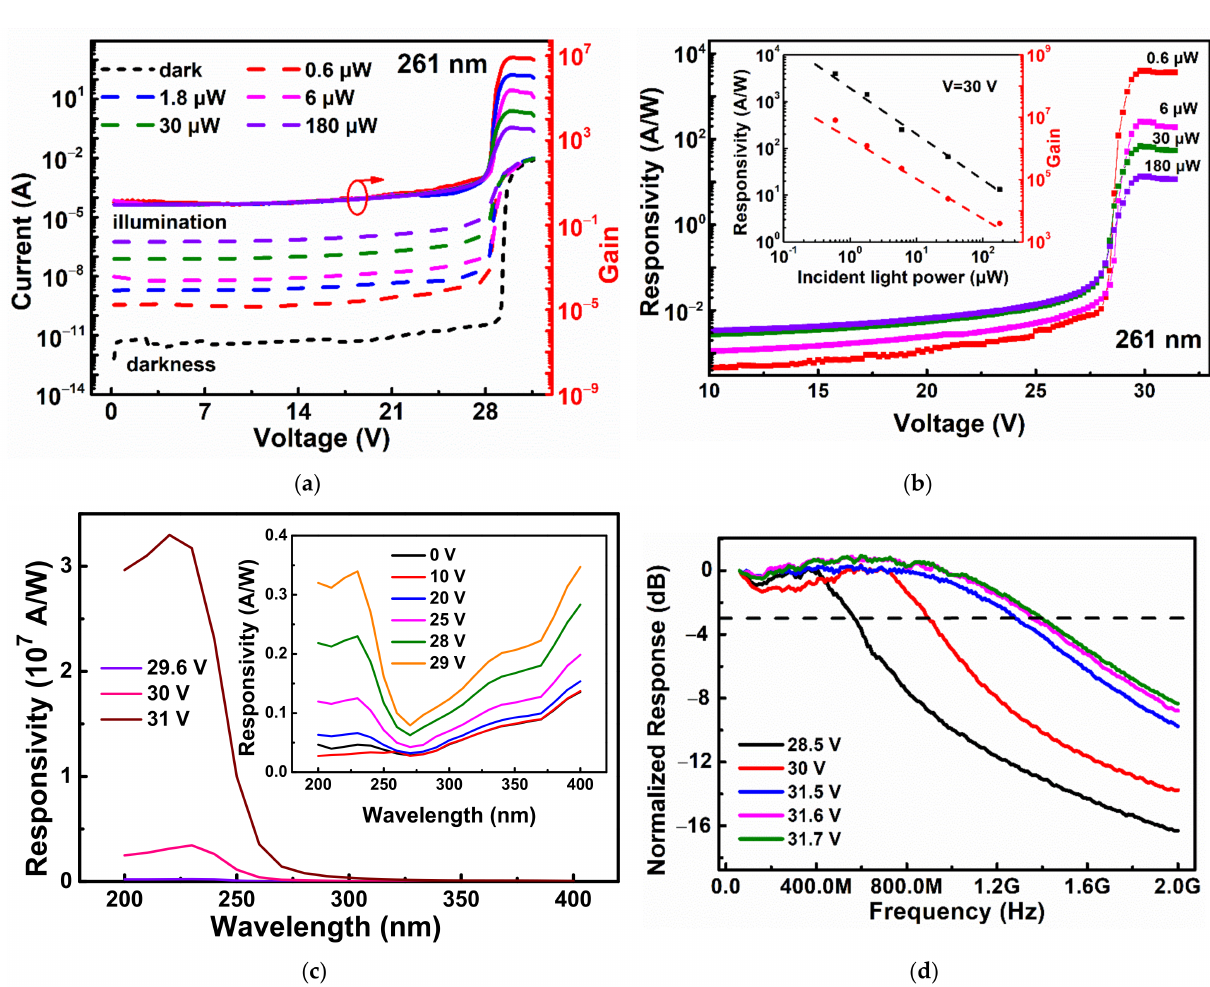
Figure 2. Photoresponse and frequency response of the APD. ( a ) Measured reverse current-voltage- gain curves of the Si APD at different incident light power (0.6 µ W, 1.8 µ W, 6 µ W, 30 µ W, 180 µ W) of 261 nm. Dark current, photocurrent, and gain are represented by black short dot, colored dash line and corresponding colored solid line, respectively. ( b ) The responsivity as a function of reverse bias under the illumination of 261 nm. Inset: Extracted responsivity and gain at 30 V from Figure 2a and the corresponding fitting results. ( c ) Spectral responsivity measurement results biased above breakdown for the incident light wavelength from 200 nm to 400 nm. Inset: Spectral responsivity biased before breakdown. ( d ) Measured optical modulation frequency response at different reverse biases when the incident light wavelength is 850 nm for the 100- µ m Si